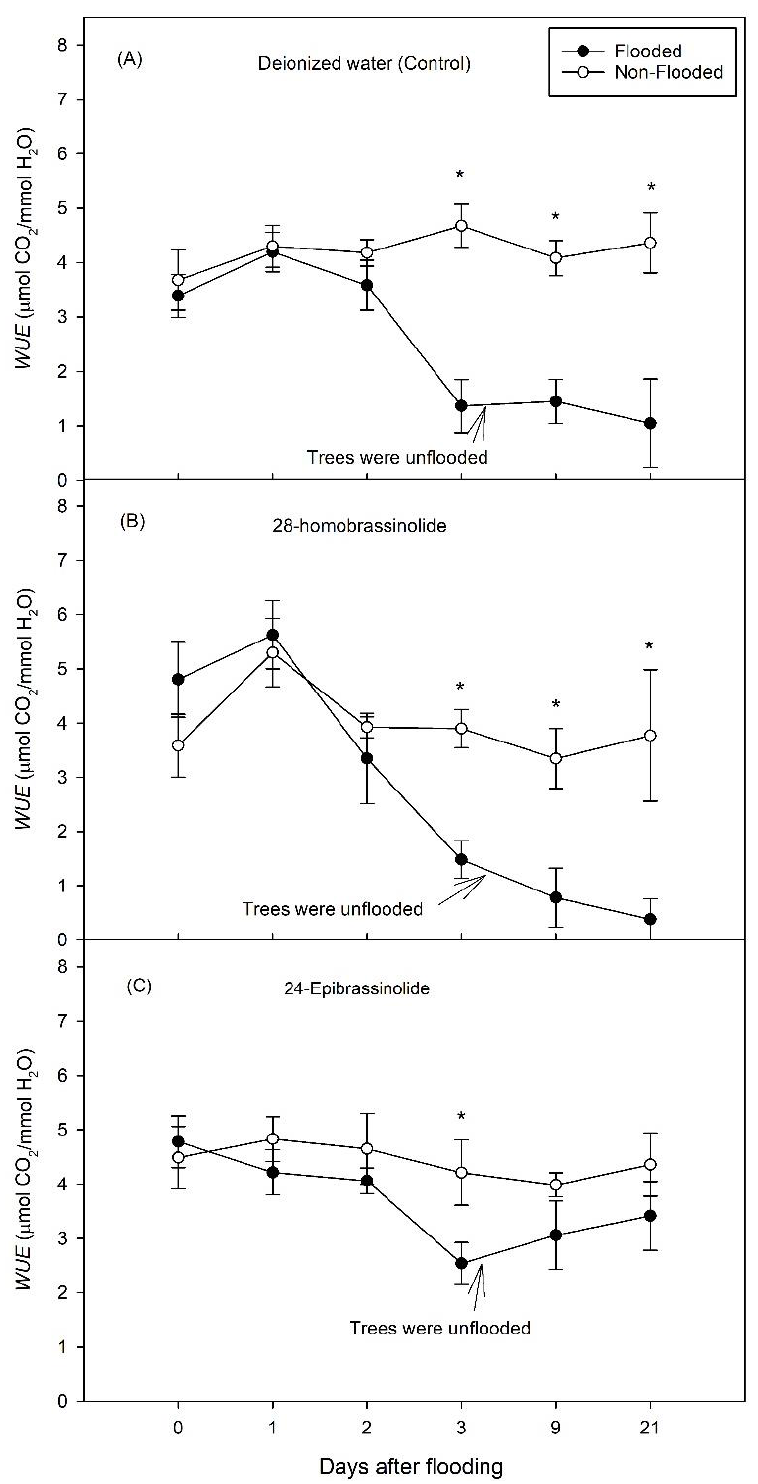
Figure 9. Effect of flooding on water use efficiency ( WUE ) of ‘Reed’ avocado trees treated with ( A ) deionized water as a control, ( B ) 28-homobrassinolide, or ( C ) 24-epibrassinolide, (Experiment 2). Symbols and bars indicate means ± std. err. Significant differences ( p ≤ 0.05) between flooding treatments are indicated with an asterisk and were determined by repeated-measures ANOVA. ‘Trees were unflooded’ indicates the day on which trees were removed from the flooding treatment to start the recovery period.